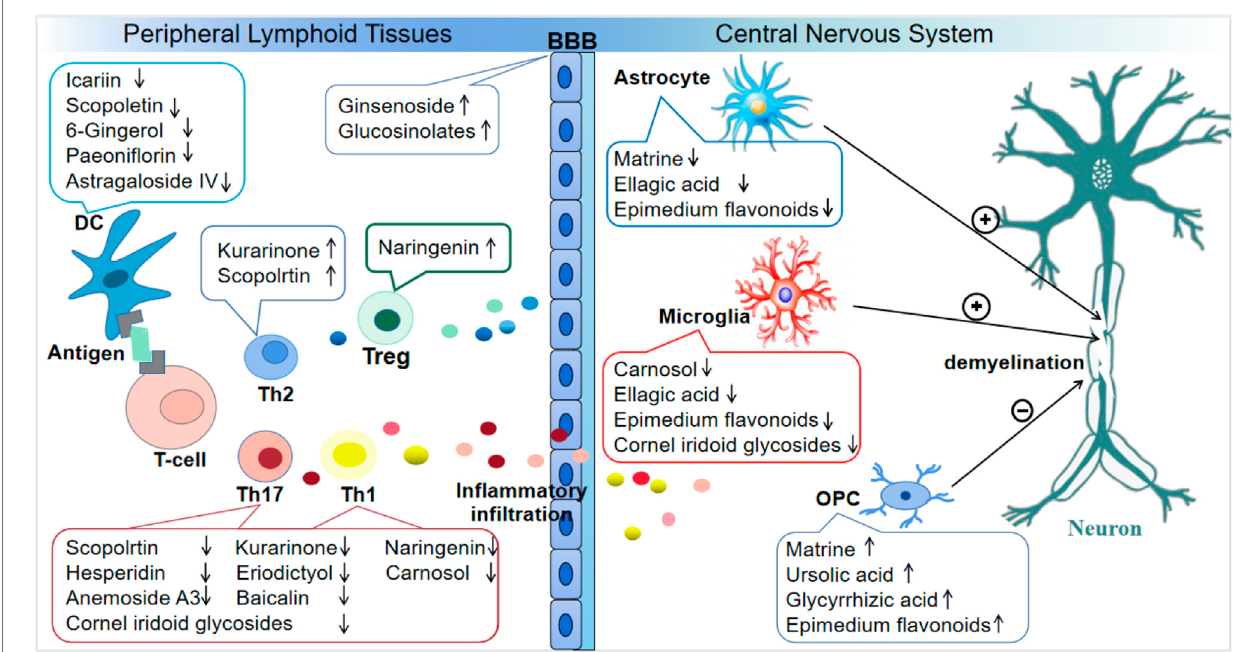
FIGURE 2 | Different monomers of TCM act on various objects in EAE.